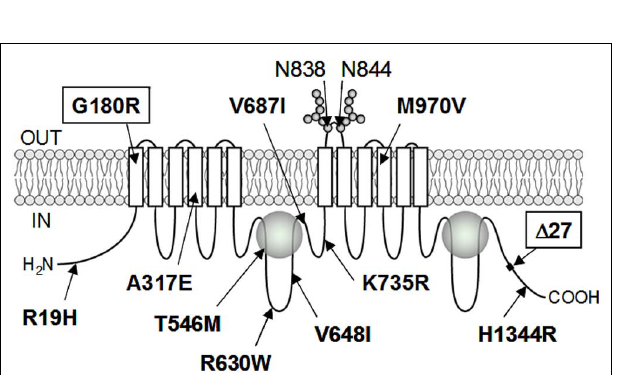
FIGURE 2 | Schematic illustration ofABCC11 protein structure and hitherto known non-synonymous SNPs. ABCC11 has a total of 12 transmembrane (TM) regions and two intracellular ATP-binding cassettes. Asn838 and Asn844 residing in an extracellular loop between transmembrane helicesTM7 andTM8 are N -linked glycosylation sites in the ABCC11WT protein. Locations of hitherto reported non-synonymous SNPs and Δ 27 (a rare deletion mutation) are indicated in the putative structure of ABCC11. G180R and Δ 27 are related to the formation of dry-type earwax.